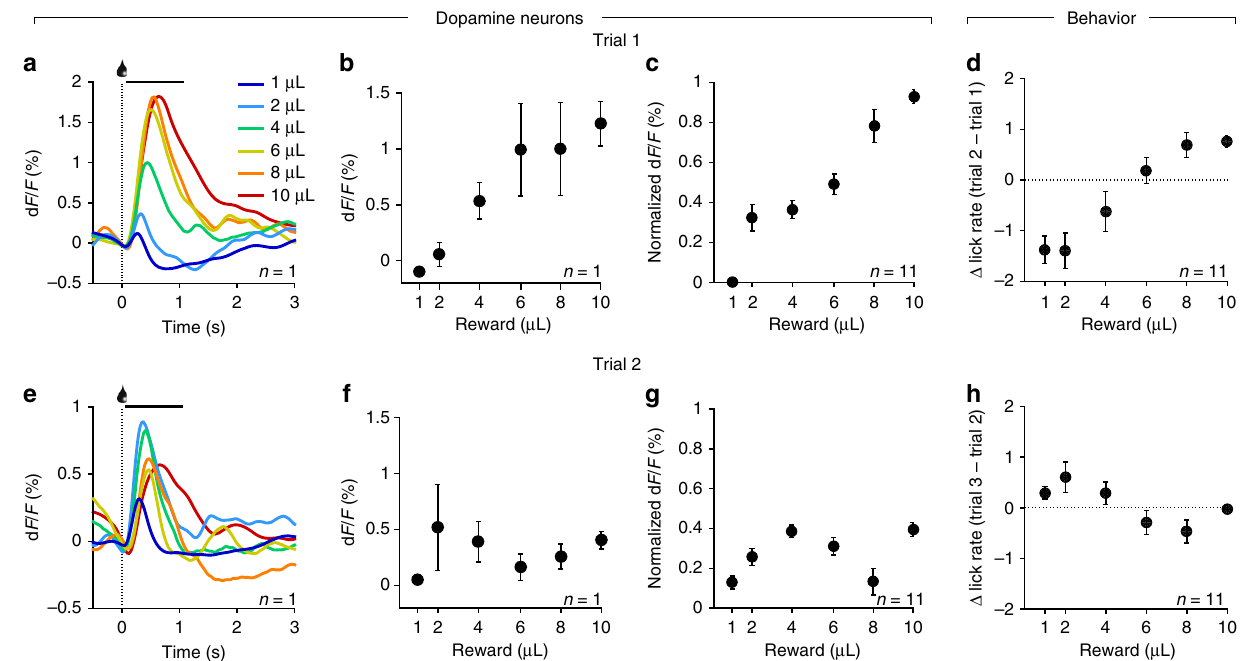
Fig. 3 Dopaminergic and behavioral signature of belief states. a – c Dopamine neurons activity on trial 1. Dopamine neurons show a monotonically increasing response to increasing rewards ( a , individual example), quanti fi ed as the mean response after reward presentation (0 – 1 s, indicated by a solid black line in a ) in the individual example ( b ) and across mice ( c ). d Change in anticipatory licking from trial 1 to trial 2. Mice increase their anticipatory licking after trial 1 proportionally to the increasing rewards. e – g Dopamine neurons activity on trial 2. Dopamine neurons show a non-monotonic response pattern to increasing rewards ( e , f , individual example), quanti fi ed across all mice ( g ). h Change in anticipatory licking from trial 2 to trial 3. Whereas mice do not additionally adapt their licking for the known trained volumes (1 and 10 μ L) after trial 2, they increase anticipatory licking for small intermediate rewards and decrease it for larger intermediate rewards in a pattern, which follows our prediction of belief state in fl uence on RPE. n = 11, data represent mean ±